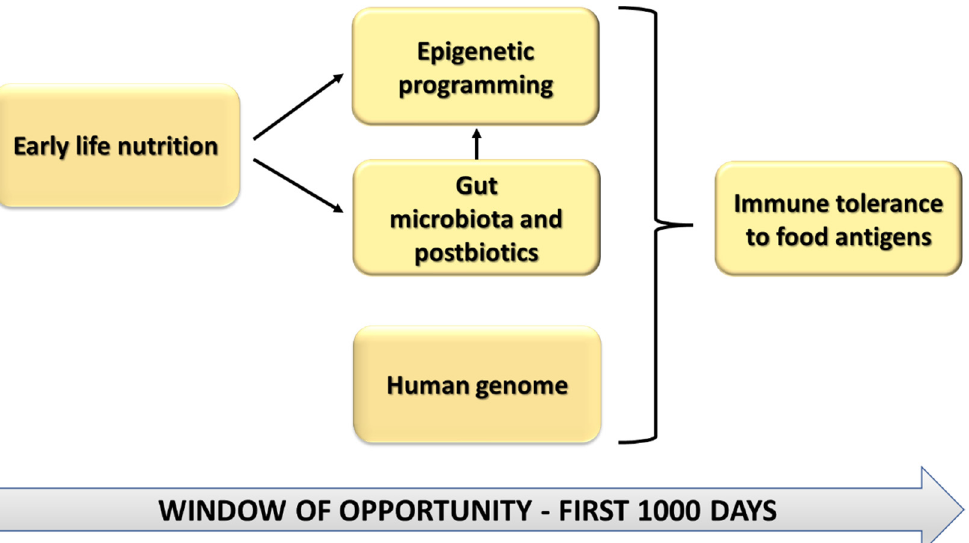
Figure 1. Interrelation among early life nutrition, human genome, gut microbiota and postbiotics, and epigenetics during the first 1000 days of life.